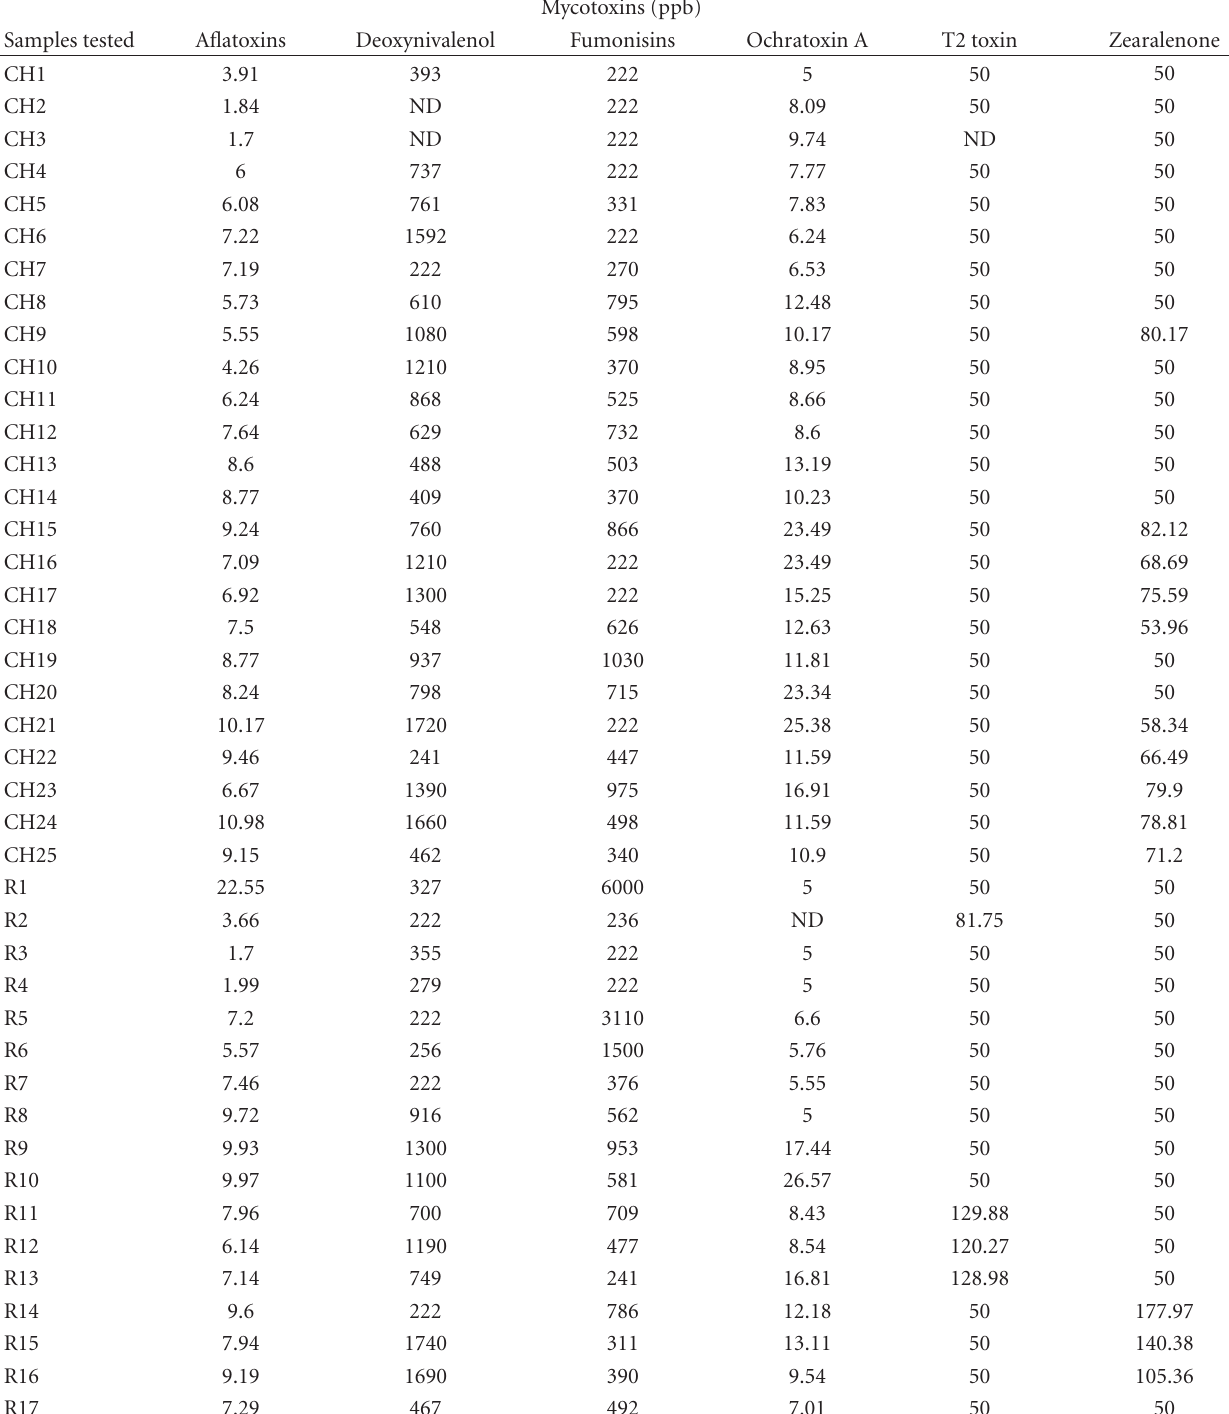
Table 5: Concentration of di ff erent mycotoxins in chinchilla and rabbit feed samples. ND: not detected; CH: chinchilla; R: rabbit. Mycotoxins